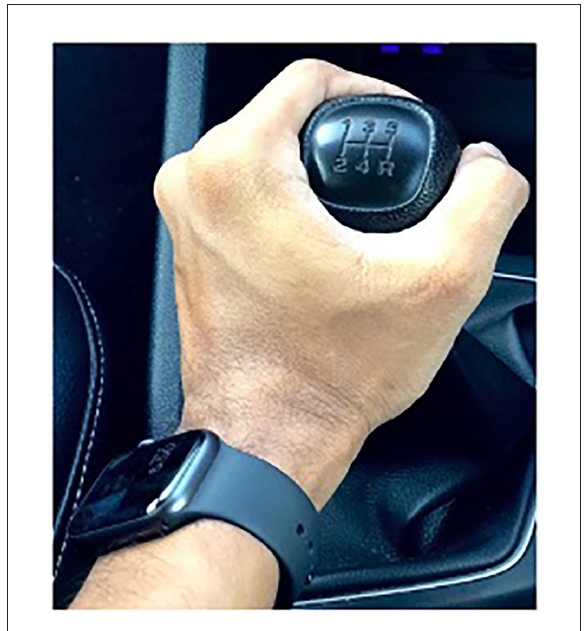
FIGURE1 Real cars. Photo credits for meme: photo by Dicson @smartdicson, https://unsplash.com/license; https://unsplash.